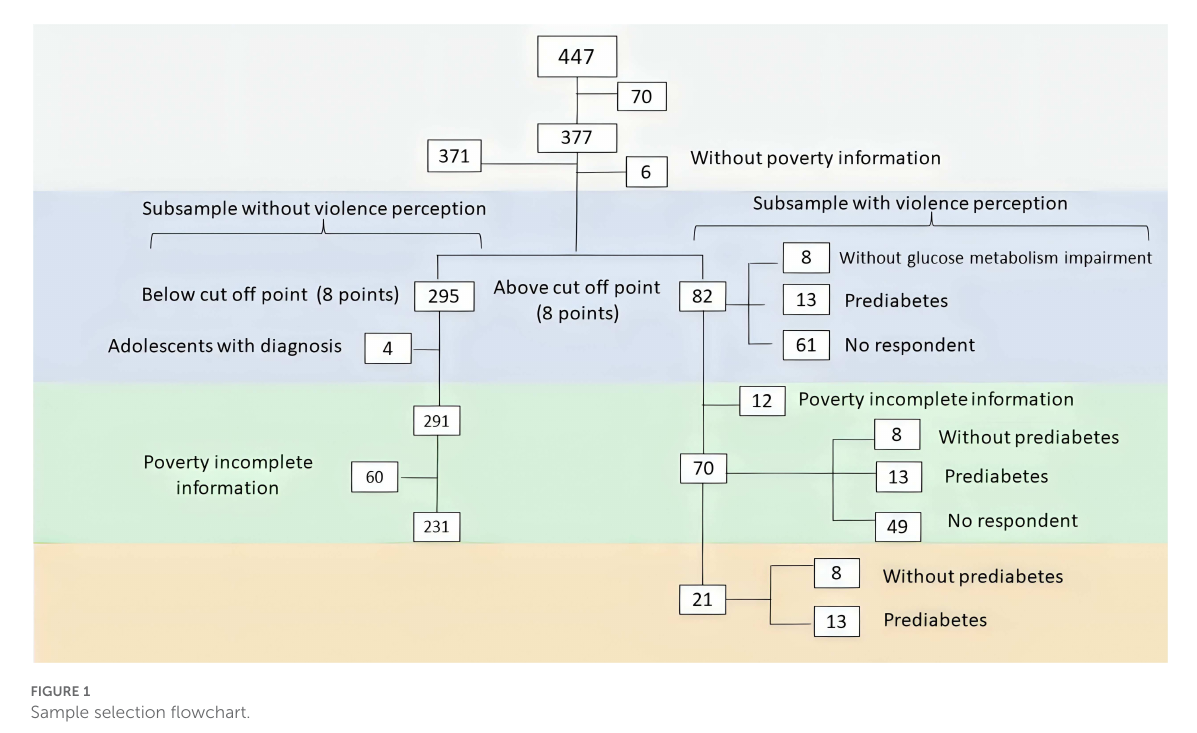
FIGURE1 Sample selection